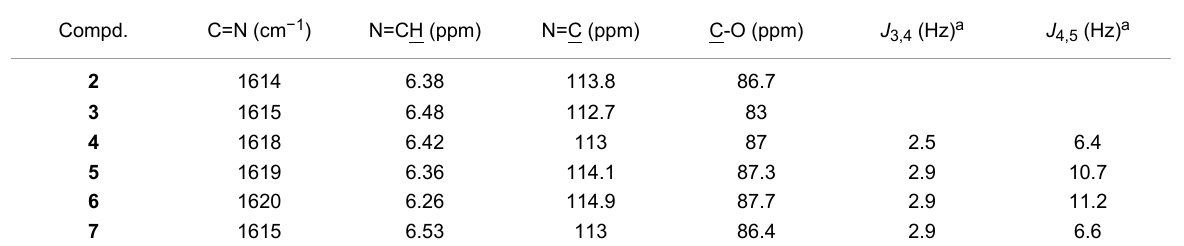
Table 2: Characteristic spectral bands for nitronic esters.